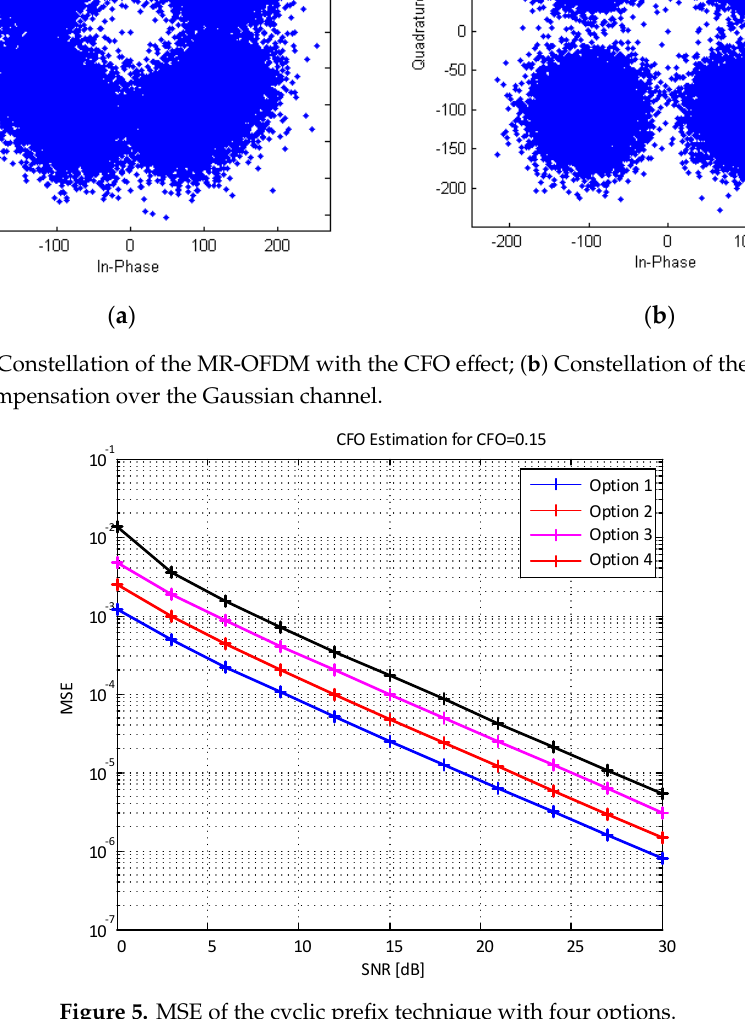
Table 2. Characteristic parameters for simulation.